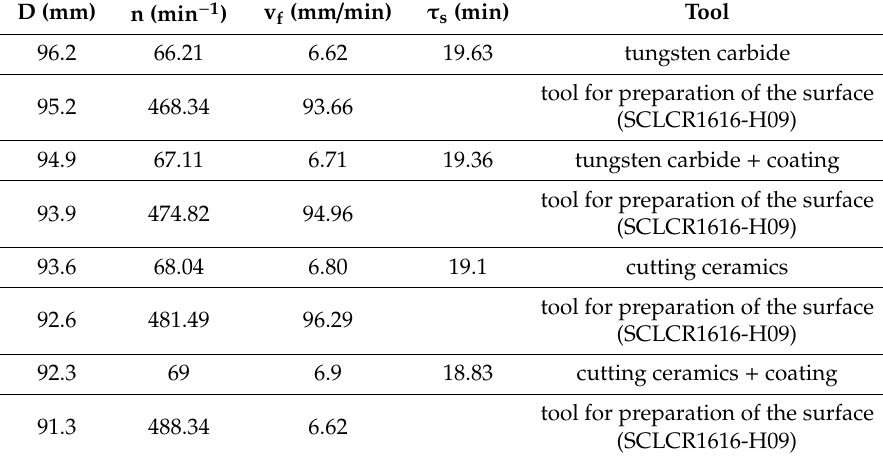
Table 6. Demonstration of data calculations—CNC